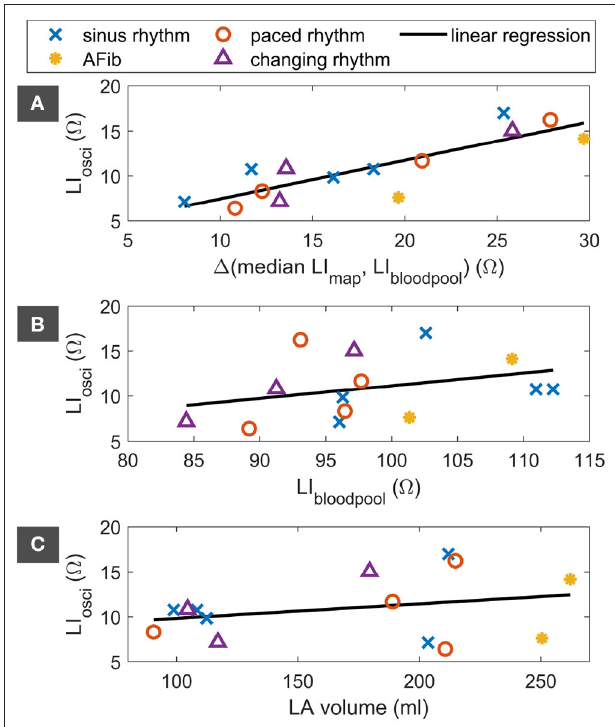
FIGURE 9 | Dependency of the median LI oscillation on the elevation of the median LI upEn of the LI map above LI bloodpool (A) , on LI bloodpool (B) , and on the LA volume (C) . Markers indicate the cardiac rhythm during map acquisition. The linear regression is displayed as black line. LI, local impedance; AFib, atrial fibrillation; LA, left